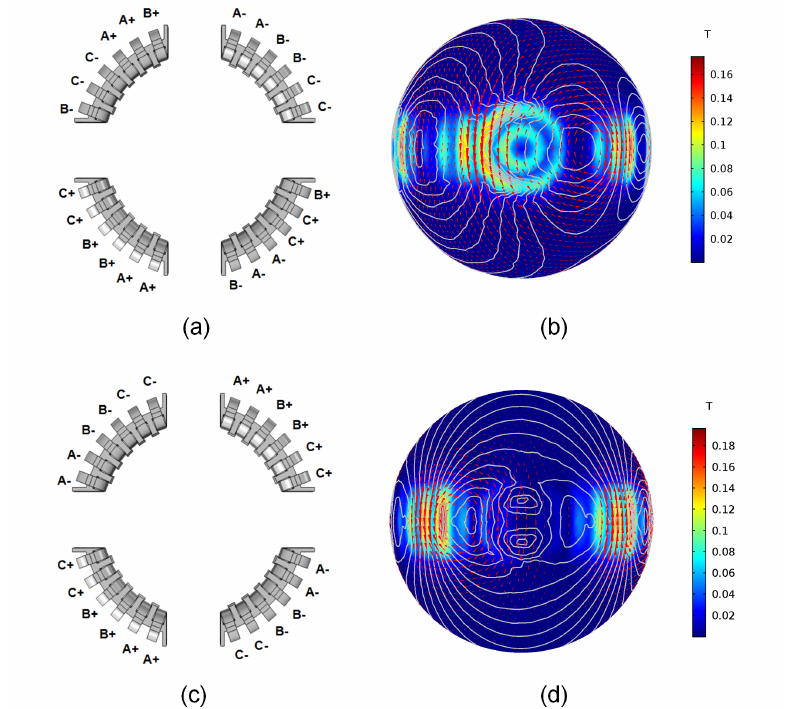
Figure 5. Winding mode and simulation of magnetic field and induced currents on the surface of the rotor: ( a ) 6-pole scheme. ( b ) Simulated distribution of 6-pole scheme. ( c ) 4-pole scheme. ( d ) Simulated distribution of 4-pole